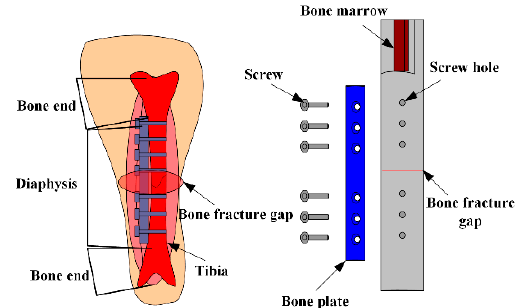
Figure 4. The repair model of sheep tibia.